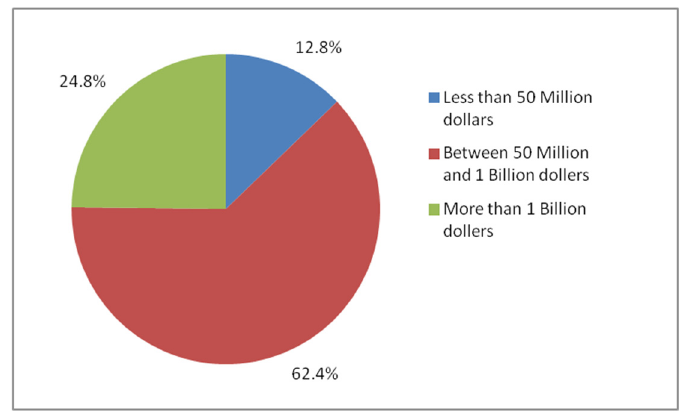
Figure 16. Organisation revenue.